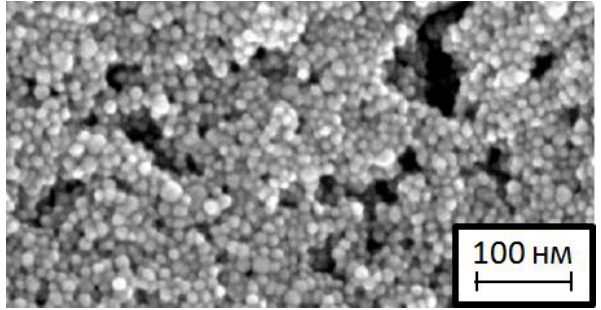
Fig. 1. SEM image of Ag nanoparticles.